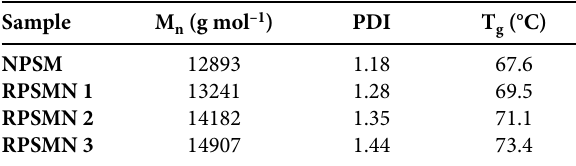
Table 5: Extracted Tg of the neat random poly (styrene-co-methyl methacrylate) and its nanocomposites Sample